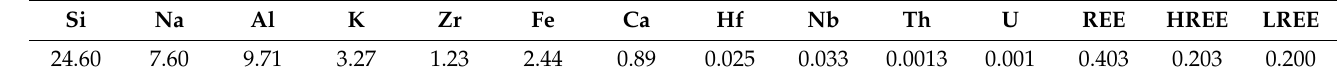
Table 1. Chemical components of interest of the Eudialyte ore sample (in wt.%).